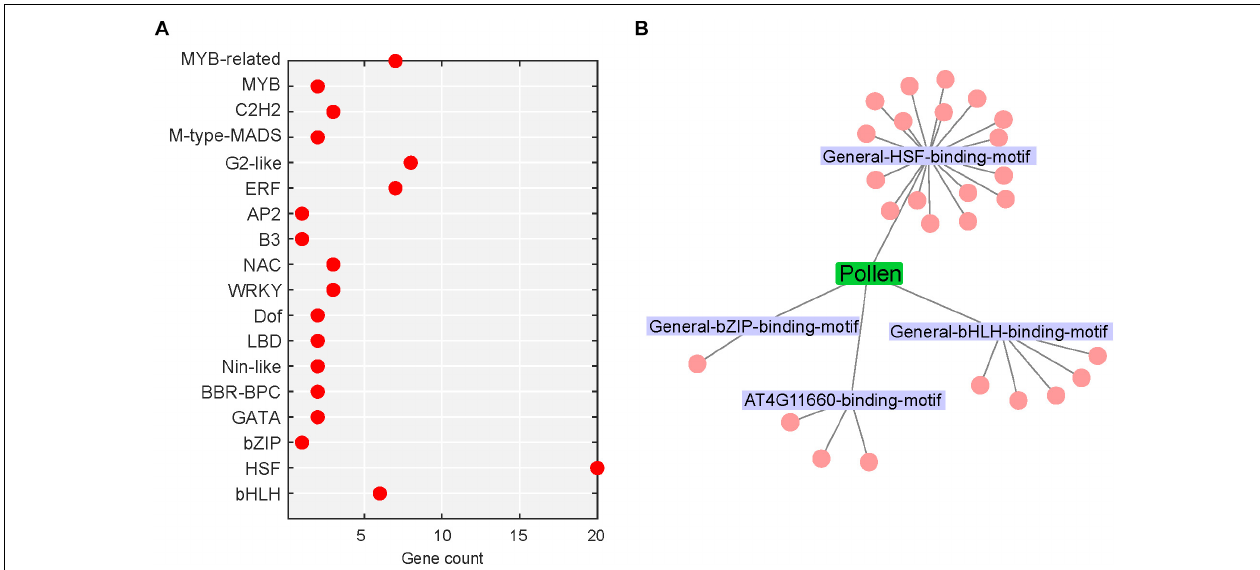
FIGURE 9 | Heat stress-regulated transcriptional cascade in pollen. (A) TFs belonging to different TF gene families differentially regulated in heat-stressed pollen; red dot represents upregulated TFs. (B) Network of enriched TFs and the associated motifs present in the promoters of heat-responsive genes in heat-stressed pollen; the motifs are labeled, and the cluster associated with a motif represents the TFs.